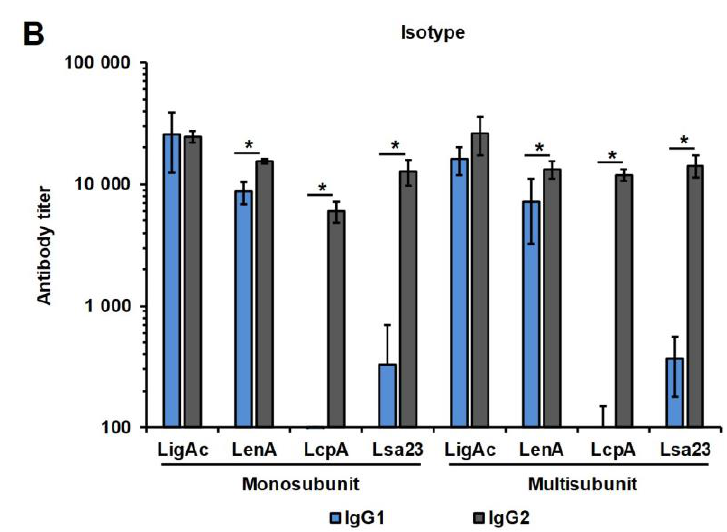
Figure 3. Antibody levels in hamsters immunized with monosubunit vaccines or vaccines containing multiple subunits of recombinant factor H binding proteins (FHBPs). The vaccines were formulated with LMQ (a combination of neutral liposome, monophosphoryl lipid A, and Quillaja saponaria fraction 21). The antibody titers at one week after the third immunization were measured by enzyme-linked immunosorbent assay (ELISA). ( A ) Antibody titers after immunizations with individual recombinant proteins as mono-FHBP vaccine or pooled recombinant FHBPs as a multisubunit vaccine; ( B ) Isotyping of anti-LigAc, LenA, LcpA, and Lsa23 IgG subclasses. The specific antibody titers to tested antigens shown (as bars) were determined by subtracting the titers for nonspecific reactivity to recombinant 6 × His tag non-FHBP (recombinant LipL32) and BSA from the total titers. The results are shown as mean ± SD. Mann–Whitney U test was used to compare antibody titer among vaccination groups; * represents p < 0 . 05 .